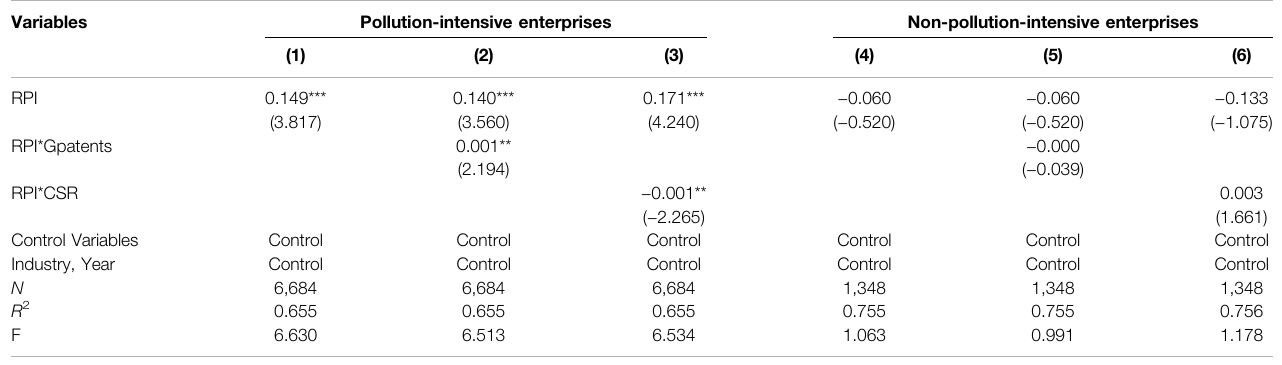
TABLE 10 | Sample regression results of different